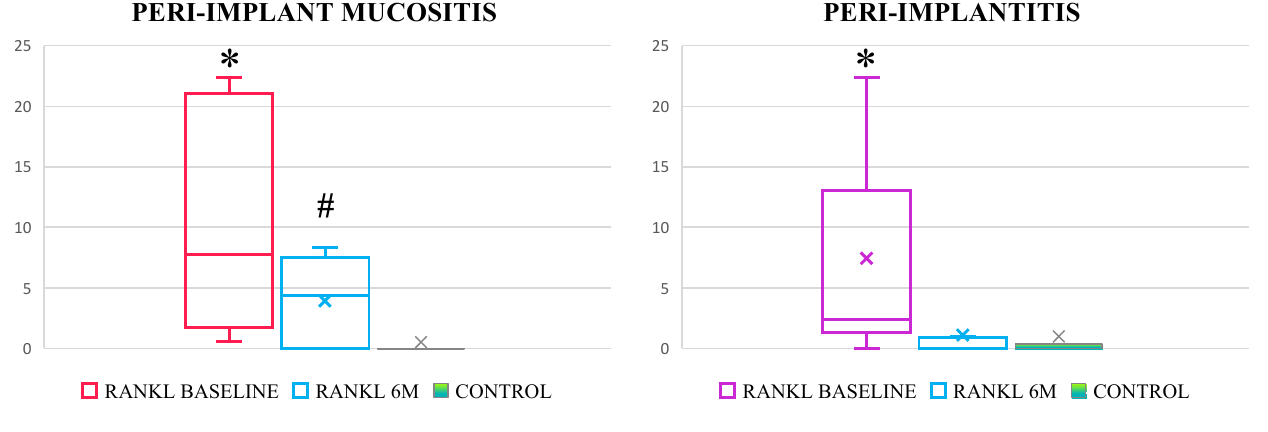
Figure 3. RANKL levels in response to standard treatment of peri-implant mucositis and peri-implantitis. RANKL concentration decreased following treatment in both groups, but respective concentration remained significantly increased in PIM. The boxplots of biomarker estimates are plotted at median values (lines), with respective confidence interval and standard deviations, while the mean values are expressed with markers (x) as well. *-significantly higher compared to post-treatment, p < 0.05; #-significantly higher compared to healthy control, p < 0.05.